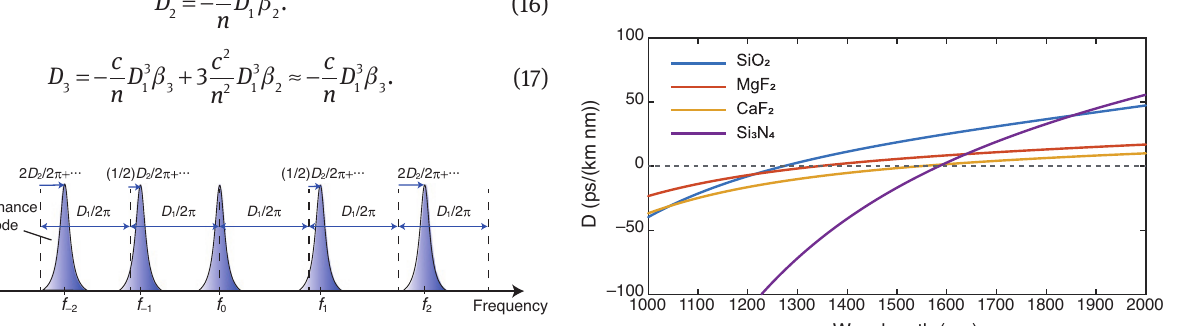
Figure 3: Material dispersion D of various platforms: silica (SiO magnesium fluoride (MgF ), calcium fluoride (CaF 2 nitride (Si N 3 4